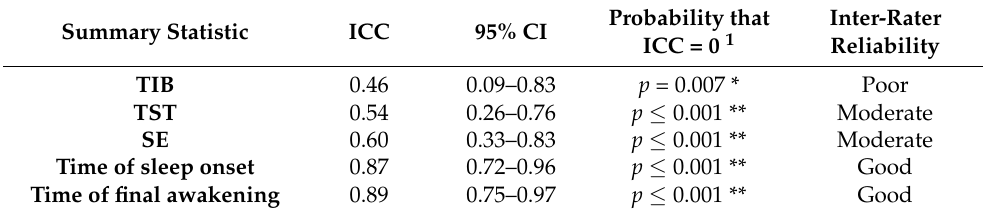
Table 4. Intraclass correlation coefficients between Zulu watch, PSG, and actigraphy.